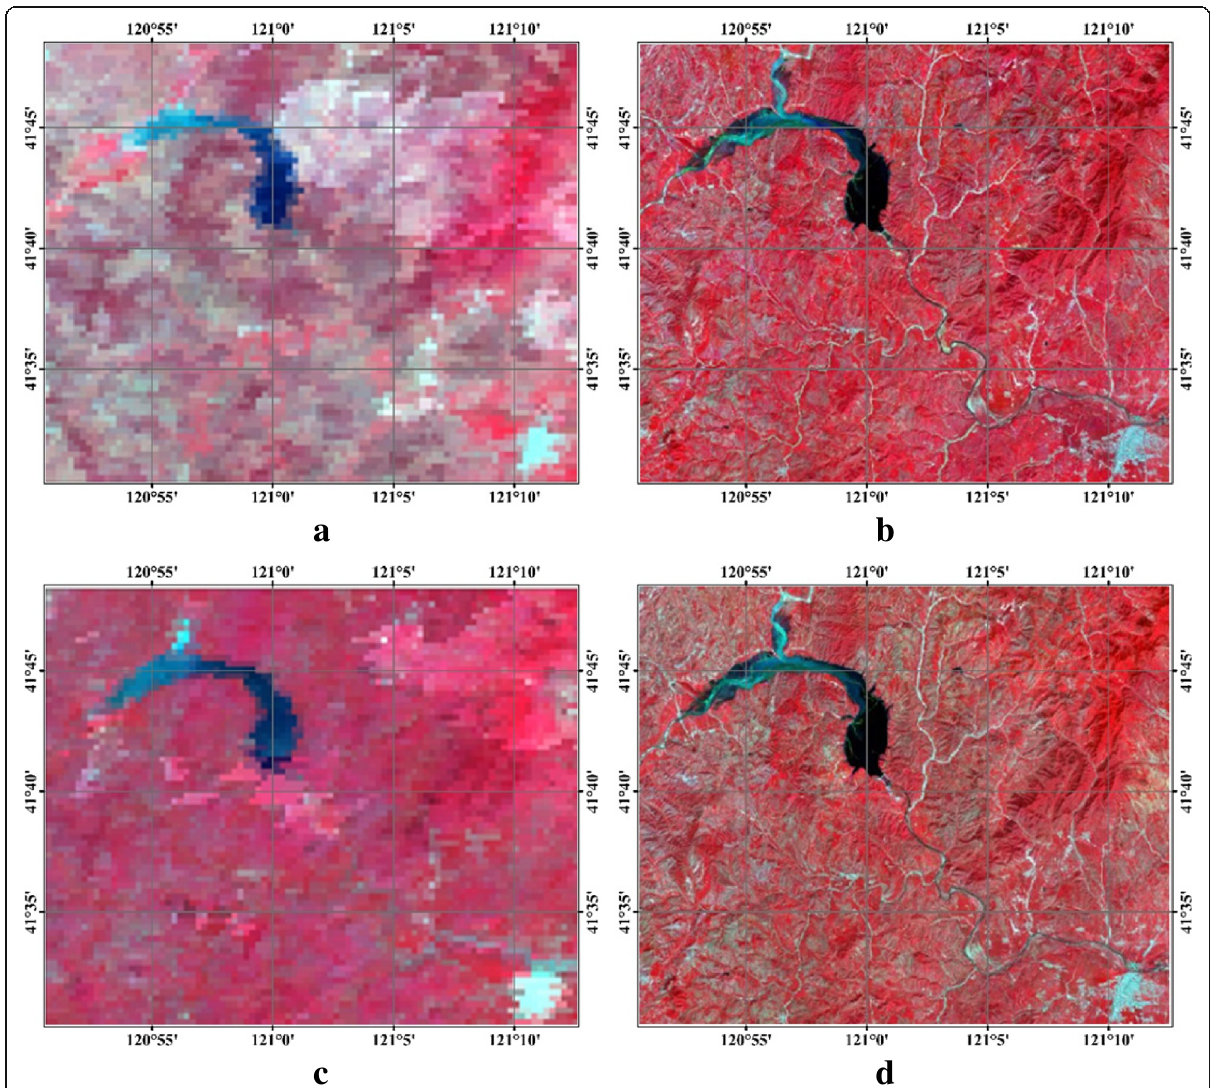
Fig. 1 The MODIS data fusion and the fusion data after false color composite in sample region. a Original MODIS image in 2016. b Fused false color synthesis in 2016. c Original MODIS image in 2014. d Fused false color synthesis in